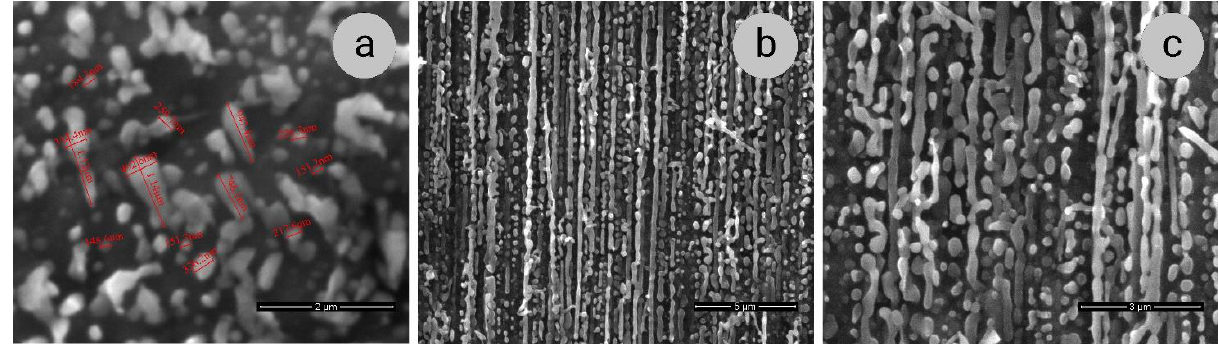
Figure 6. SEM images of Sample 2 ( e = 12.5) after the annealing at 800 ◦ C, 1 h: ( a )—transverse section; ( b , c )—longitudinal sections.